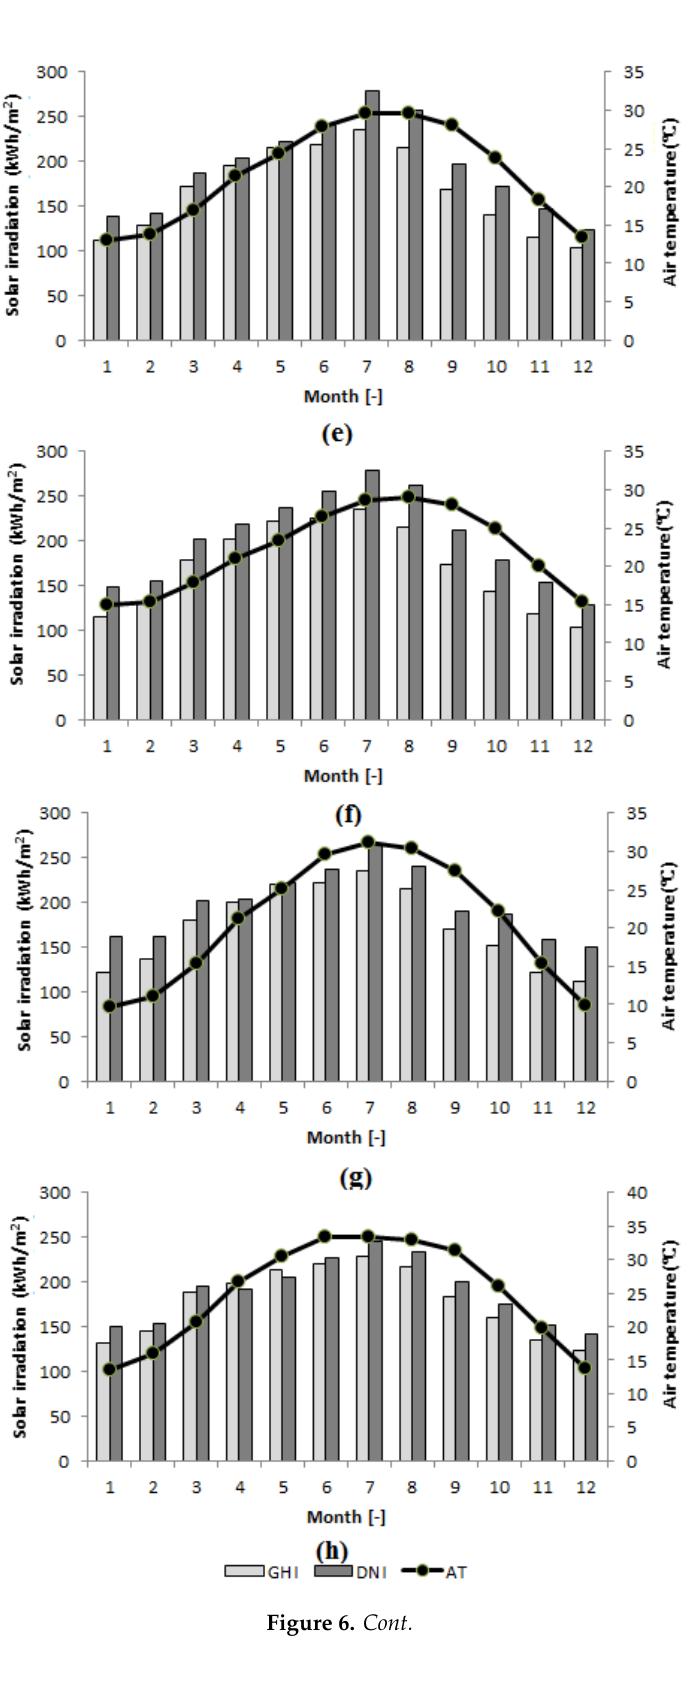
Figure 6. Figure 6. Continued.